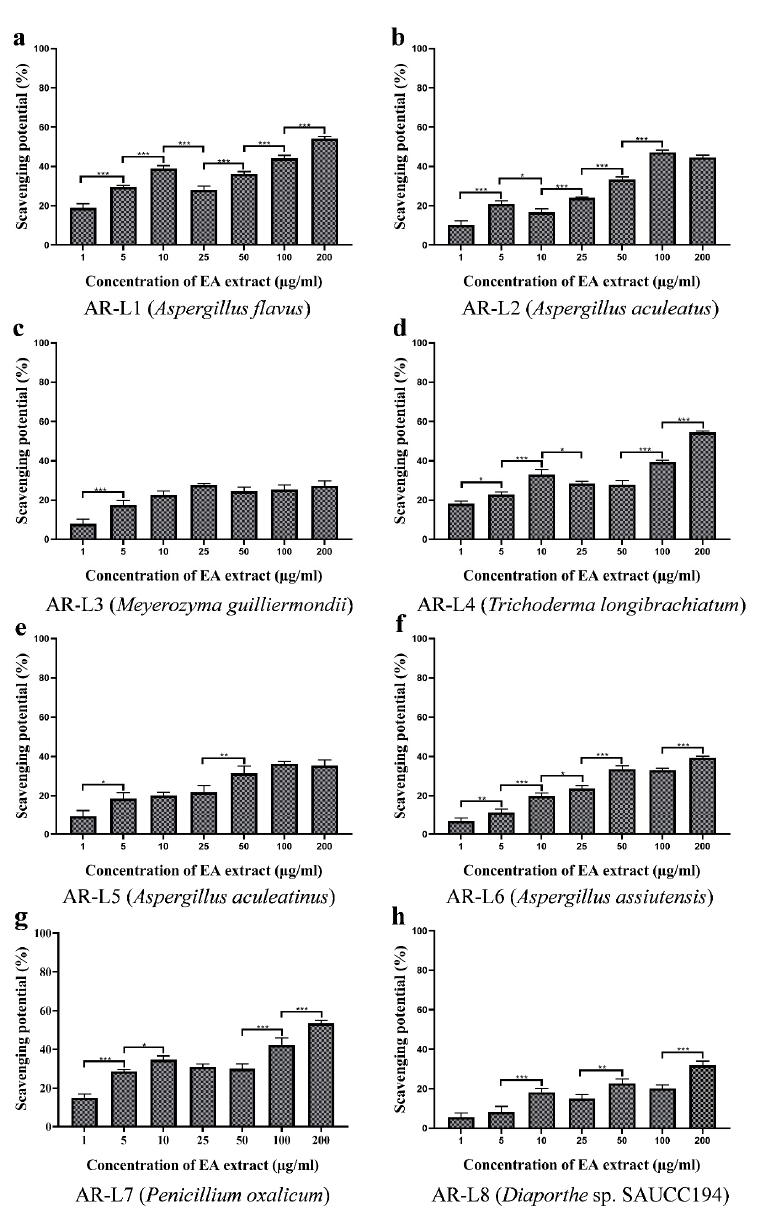
Figure 4. Superoxide anion scavenging potential of EA extract of fungal endophytes ( a ) A. flavus , ( b ) A. aculeatus , ( c ) M. guilliermondii , ( d ) T. longibrachiatum , ( e ) A. aculeatinus , ( f ) A. assiutensis , ( g ) P. oxalicum and ( h ) Diaporthe sp. SAUCC194. All the experiments were performed in triplicate. p -value was calculated by comparing means ± SD of the superoxide anion radical scavenging potential (%), using one-way ANOVA followed by Tukey to determine statistical significance, which are as follows; *** p ≤ 0.001; ** p ≤ 0.002; * p ≤ 0.033.